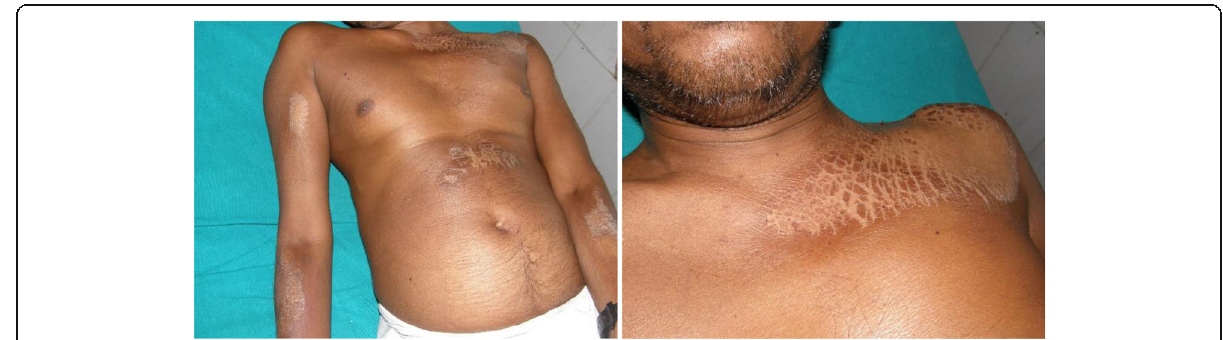
Fig. 2 Multiple well define macules predominantly involving the photo distributed areas like arm, forearm, left shoulder and epigastric region with dry overlying surface